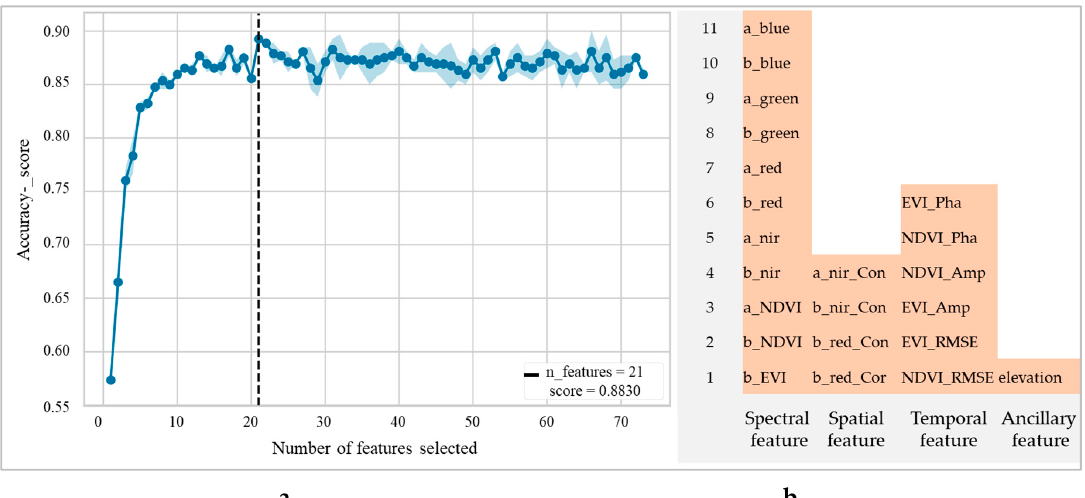
Figure 4. Feature selection using random forest-recursive feature elimination (RF-RFE) algorithm. ( a ) Optimal number of features; ( b ) spectral-spatial-temporal (SST) feature set obtained. n_features represents the number of features used in the RF-RFE algorithm. In (b), a_ and b_ represent different periods. For example, a_blue represents the blue band from the image composited between April and September.